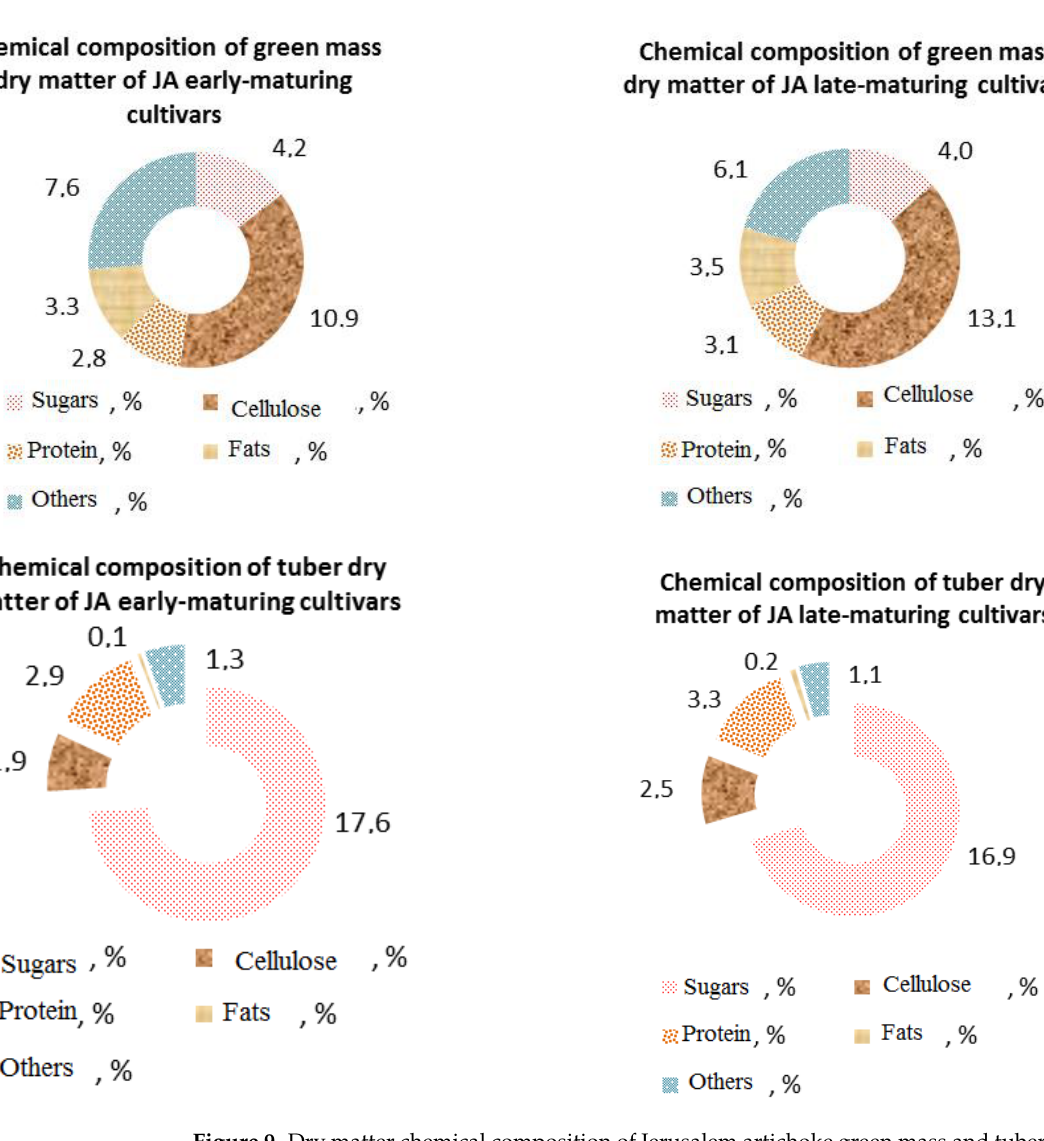
Figure 9. Dry matter chemical composition of Jerusalem artichoke green mass and tubers considering the period of herbage wilting (average by groups).